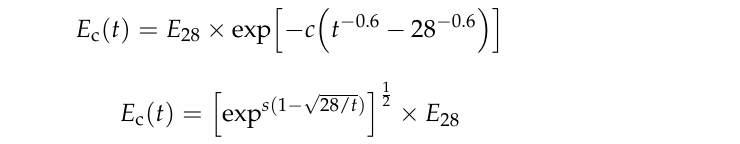
Figure 6. Stress-strain relationships for different ages of shotcrete [15]. Figure 6. Stress ‐ strain relationships for different ages of shotcrete [15].